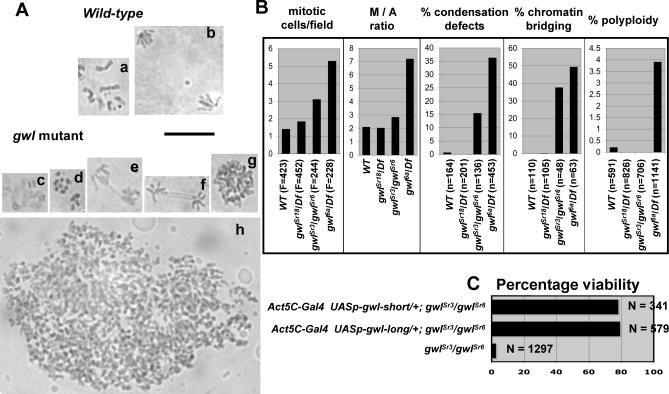
Gwl Is Required for Normal Mitosis in Somatic Tissues(A) Chromosomal defects and polyploidy observed in gwl mutant larval neuroblasts following orcein DNA staining. Control prometaphase (a) and anaphase (b) figures are shown, with normal condensation. Examples of undercondensation (c), overcondensation (d), anaphase bridges (e and f) and polyploidy (g and h) observed in gwl mutants are shown. The scale bar is for all images and shows 10 μm.(B) Quantitation of defects observed in larval neuroblasts for WT (control), gwlSr18 (female germline specific), gwlSr3/gwlSr6 (partial loss of function), and gwl6a/Df (complete loss of function). Mitotic cells were recognized by their condensed chromatin. The M/A ratio corresponds to the number of prometaphase and metaphase cells over the number of anaphase and telophase cells (F = number of fields scored). % condensation defects, number of mitotic cells with under- or overcondensation/total number of mitotic cells (n); % chromatin bridging, number of bridged anaphases/total number of anaphases (n); % polyploidy, number of polyploid mitotic cells/total number of mitotic cells (n).(C) Rescue of gwlSr3/gwlSr6 mutants by the expression of UASp-gwl-long or UASp-gwl-short from the ubiquitous Actin5C-Gal4 driver. The percentages of expected adult progeny of the indicated genotypes if the viability was normal is shown (numbers at the end of each bar indicated the total number of internal reference progeny flies scored). See Text S1 for details.